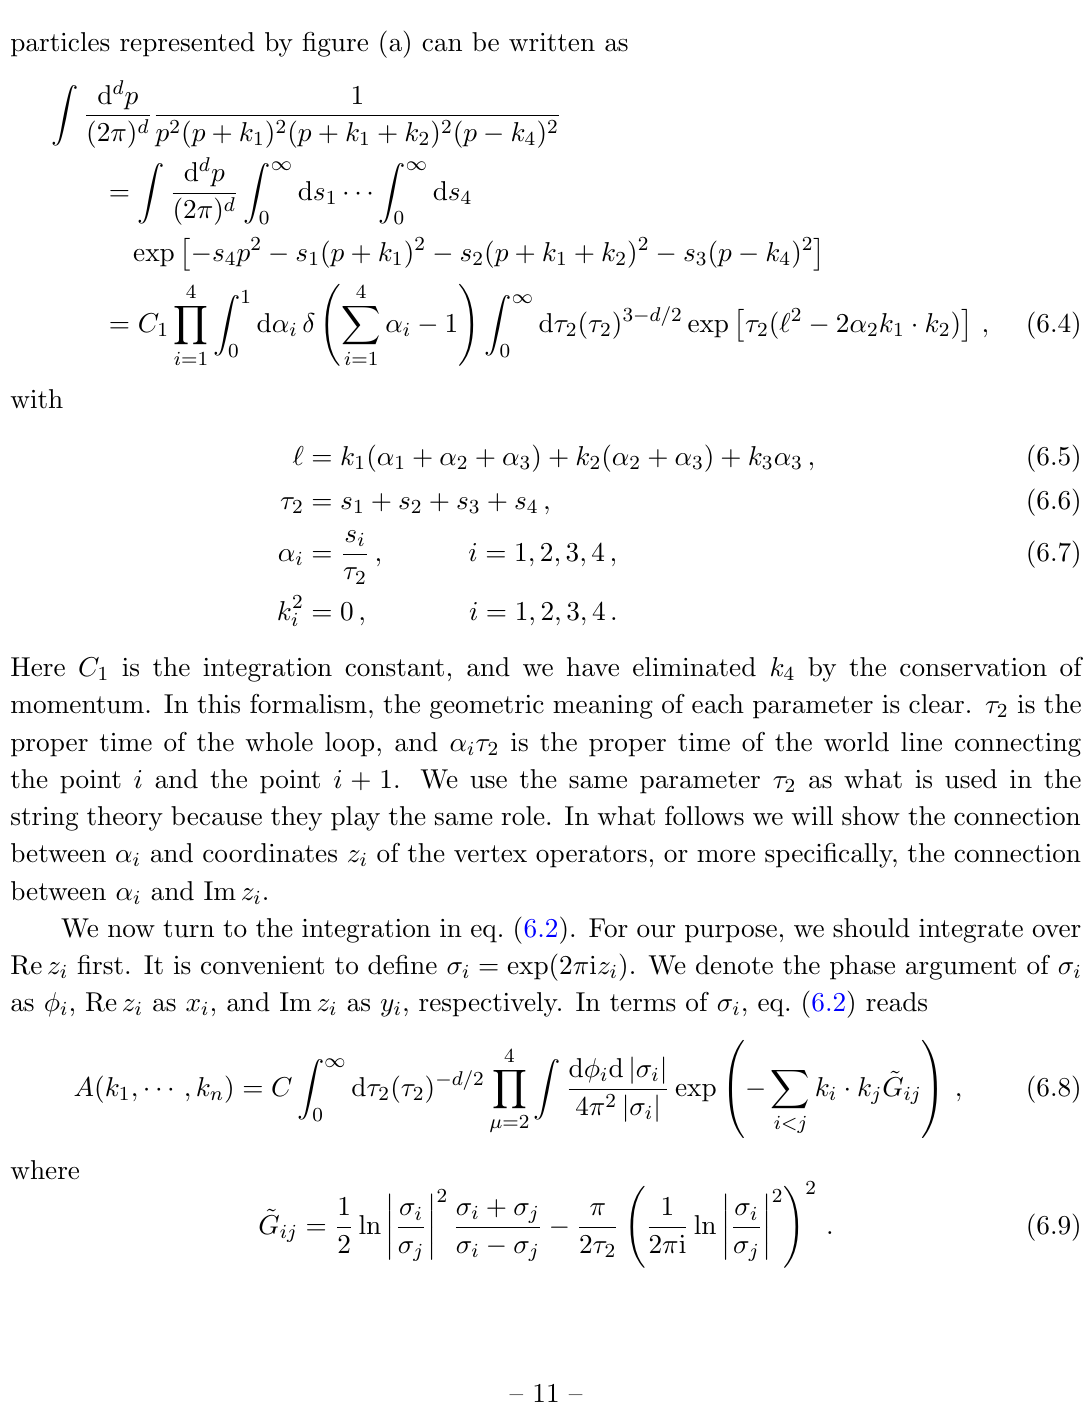
Figure 2 . Feynman diagrams for the 4-point one loop null string